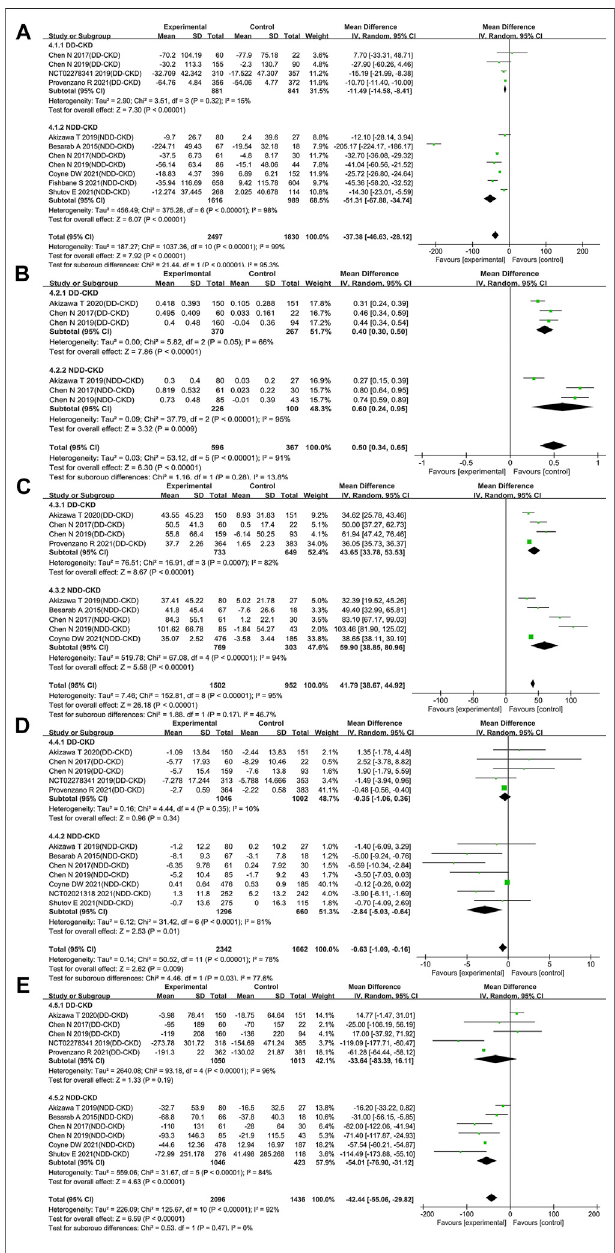
FIGURE 4 | Effect of roxadustat compared with ESA or placebo on iron utilization parameters in CKD patients. Iron utilization parameters included hepcidin (A) transferrin (B) TIBC (C) TSAT (D) and ferritin (E) . Notes: CKD, chronic kidney disease; DD-CKD, dialysis-dependent chronic kidney disease; NDD-CKD, non-dialysis-dependent chronic kidney disease; TIBC, total iron-binding capacity; TSAT, transferrin saturation.